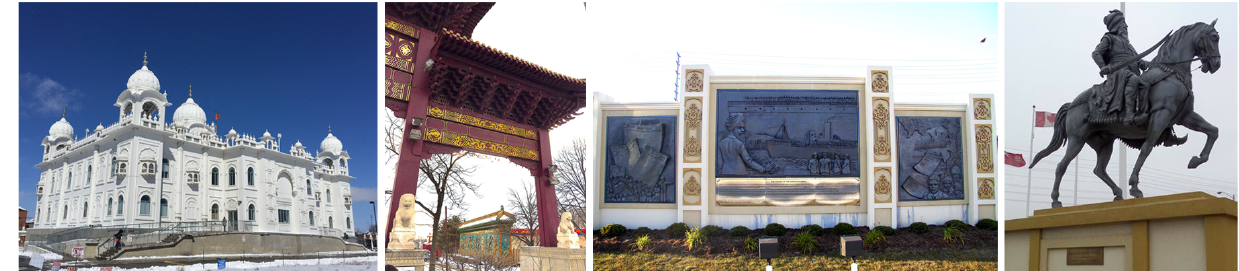
Figure 2. Cultural expressions in architectural features and public arts. Note: From left to right: Sikh Gurdwara; Mississauga Chinese Centre; and Monument and sculpture at the Great Punjab Business Centre. Source: